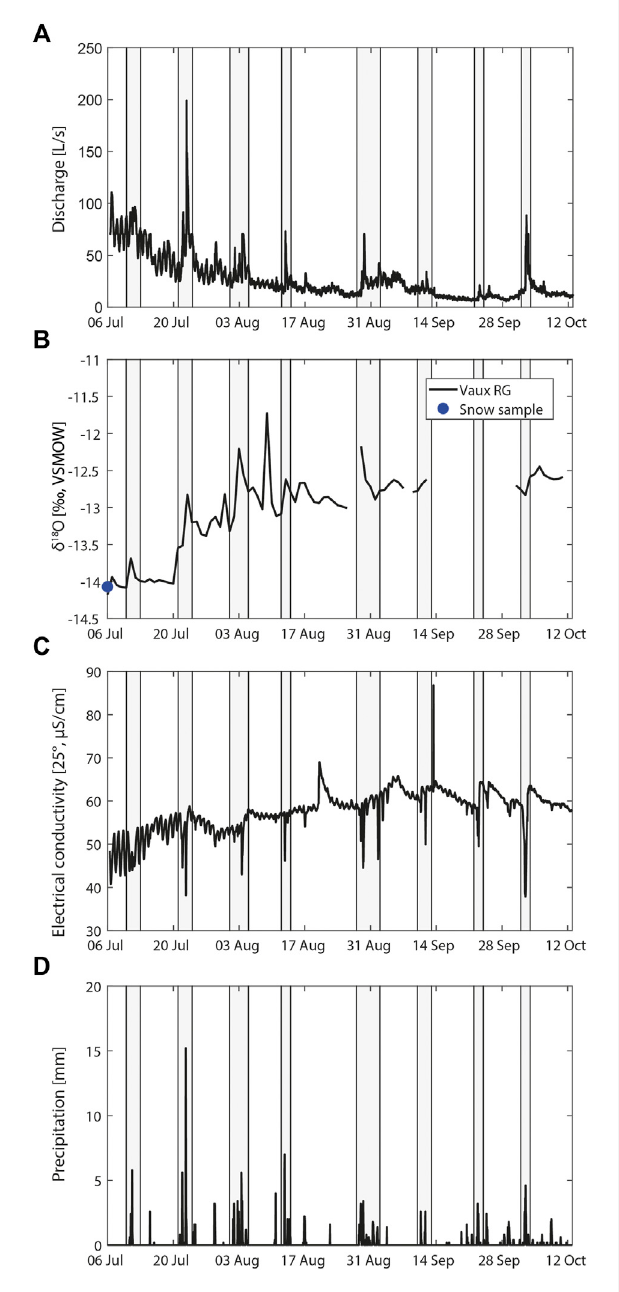
FIGURE 5 High-resolution monitoring at Vaux RG spring: (A) discharge (source: Franchini, 2022), (B) isotopic content (missing data correspond to samples that were lost due to instrument problems) and (C) electrical conductivity. Hourly precipitation measured at the Lac the Vaux station (D) arealsoreported(source:SwissFederalInstituteforSnowand Avalanche Research SLF). Grey bars indicate correlation between major rainfall events and changes in measured